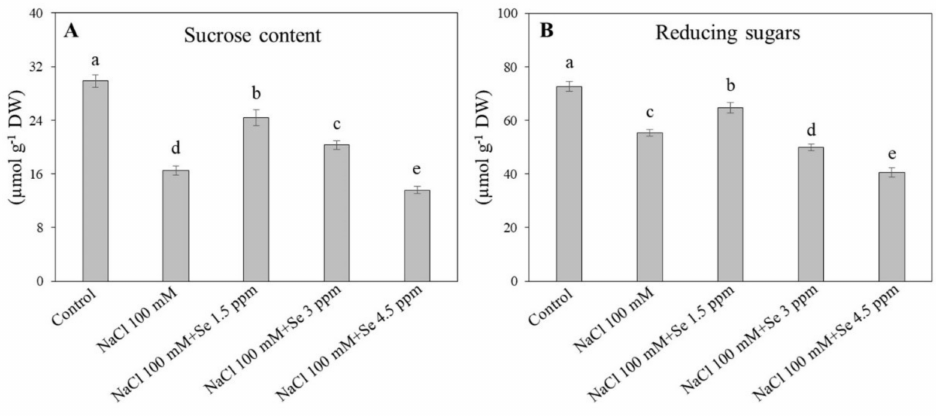
Figure 6. E ff ect of selenium (Se) fertilization on ( A ) sucrose content and ( B ) reducing sugars in leaves of black gram plants under salt stress. Values are mean ± standard error ( n = 3). Di ff erent letters in vertical columns show a significant di ff erence. A comparison of mean was confirmed by LSD at p < 0.05.